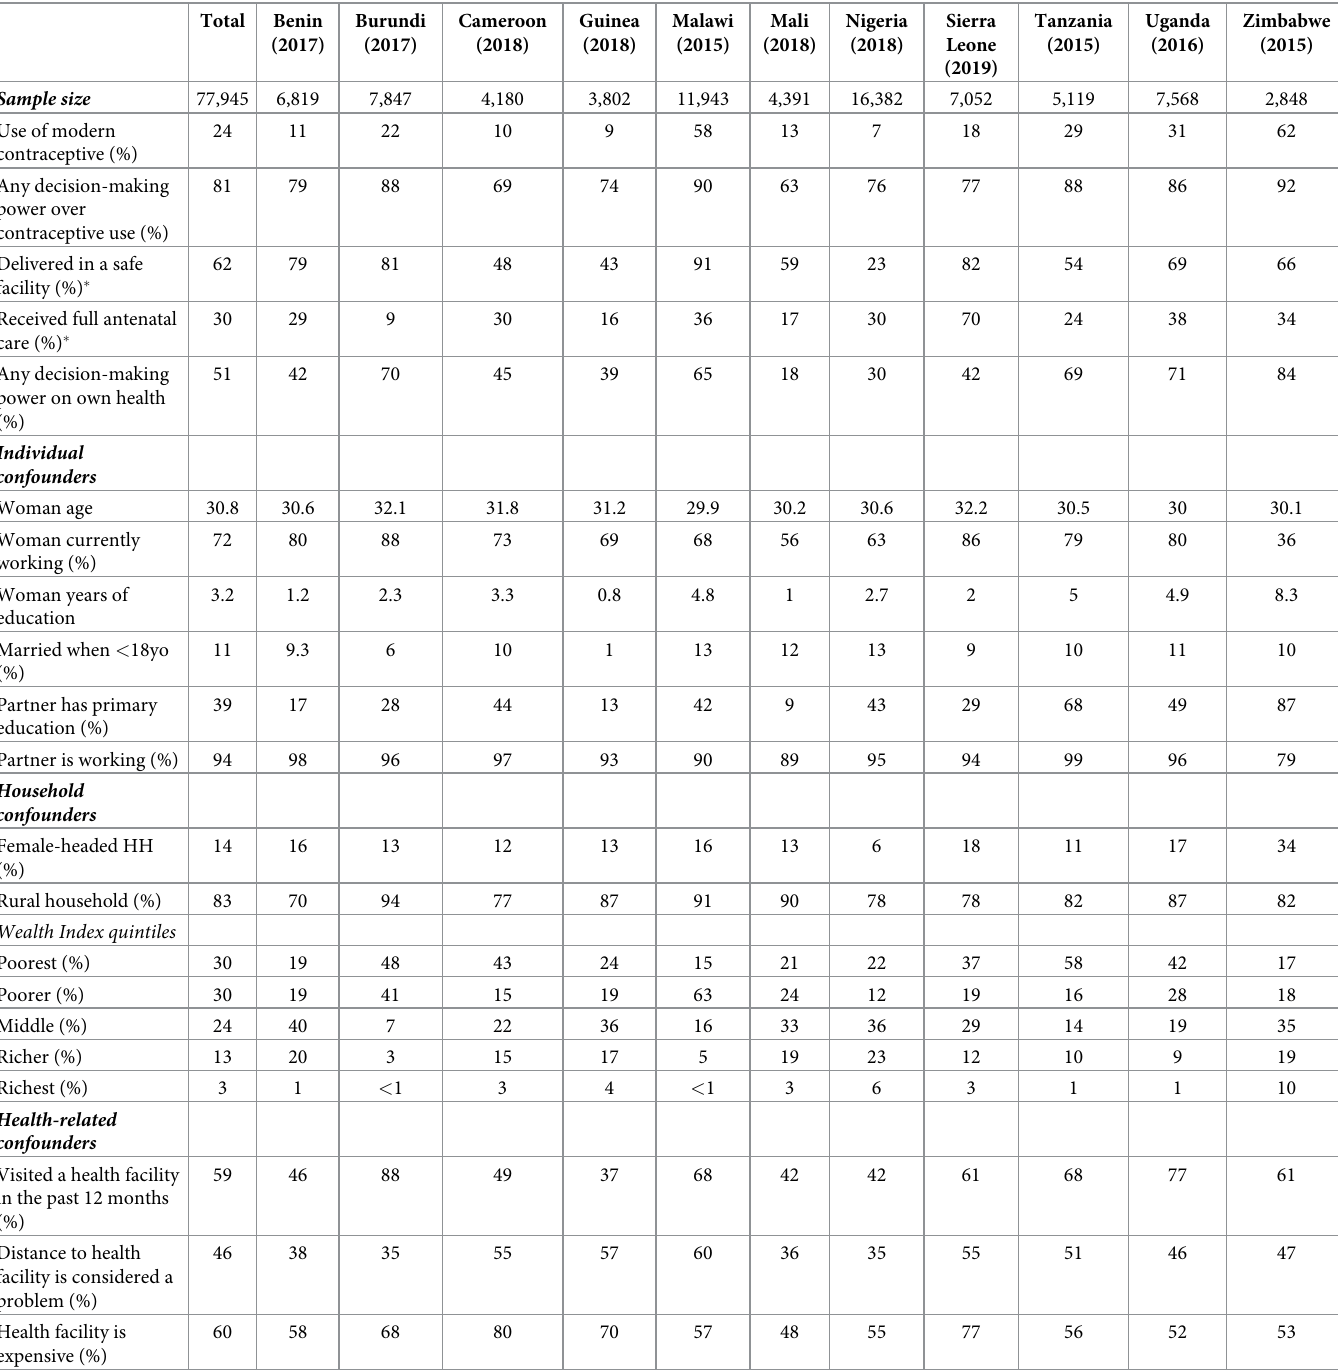
Table 1. Descriptive statistics of the sample, outcomes, mediators, and